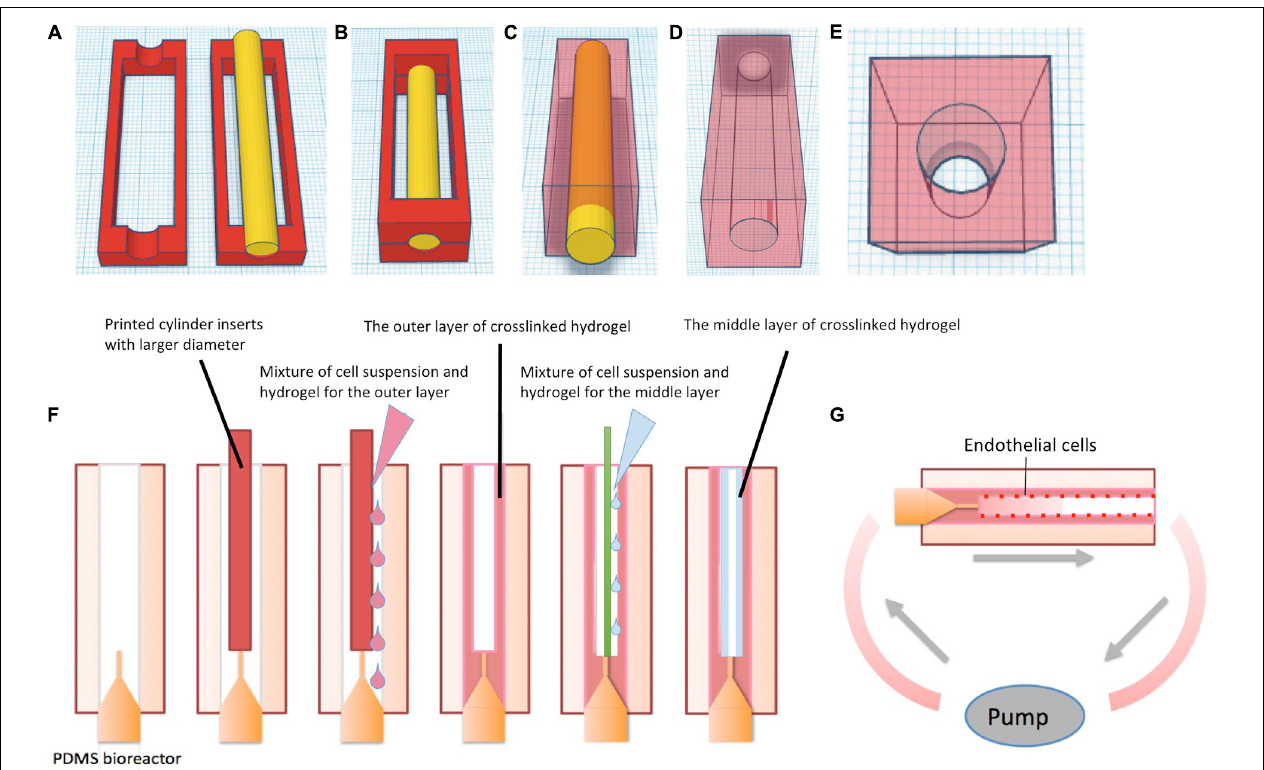
FIGURE 2 | Schematic of fabricating PDMS bioreactor and multi-layer vessel structure in hydrogel constructs in PDMS bioreactors. (A) 3D design and printing of molds. (B) Assembling of the molds and the insert for chamber creation, the mixture of silicone base and curing agent was added into the surrounding space of the insert. (C) After curing time, the outer molds were removed from PDMS. (D) Gross-view of the PDMS bioreactor1. (E) Gross-view of the PDMS bioreactor2. (F) Fabricating single vessel with multilayer hydrogels via molding technique in PDMS bioreactors. (G) Culture of hydrogels with multi-layer vessel structure in PDMS bioreactor under continuous